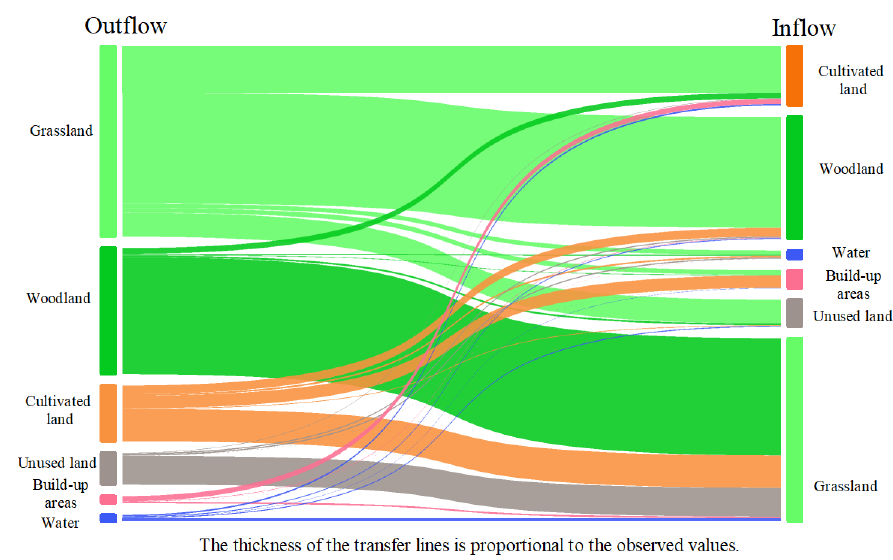
Figure 4. Transformation distribution of different land use from 1990 to 2018. Table 2. Land use transfer matrix in ecological function zones of the Upper Yellow River from 1990 to 2018. Type of Land Use